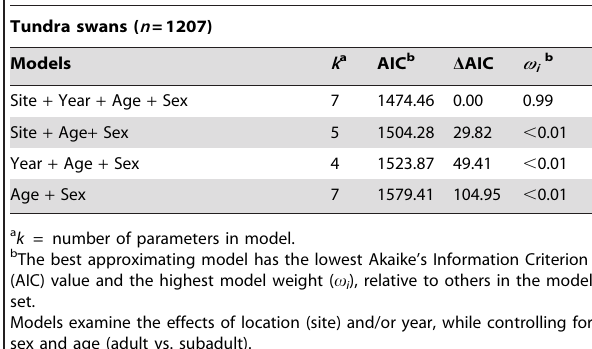
Table 3. Logistic regression models of variation in avian influenza virus (AIV) seroprevalence for tundra swans sampled in Alaska, USA, 2008–2010.